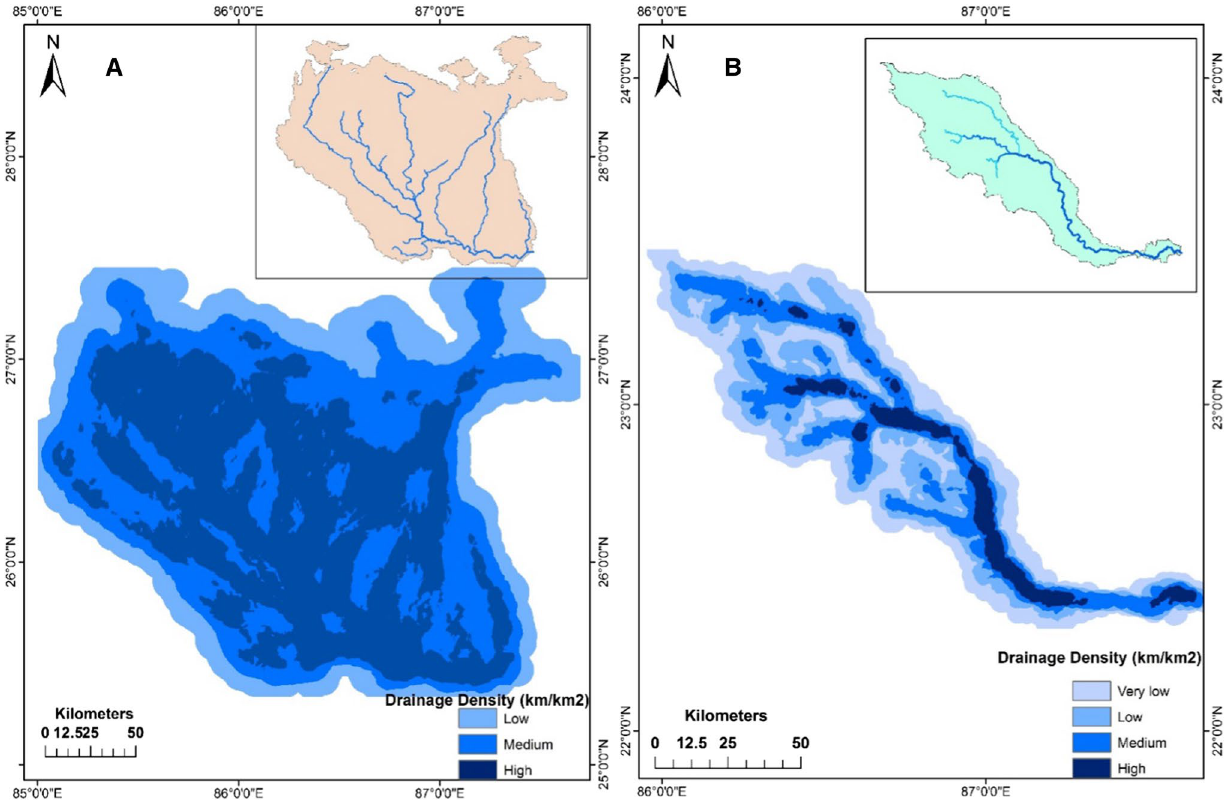
Fig. 5 Drainage density characteristics of River basins a Kosi and b